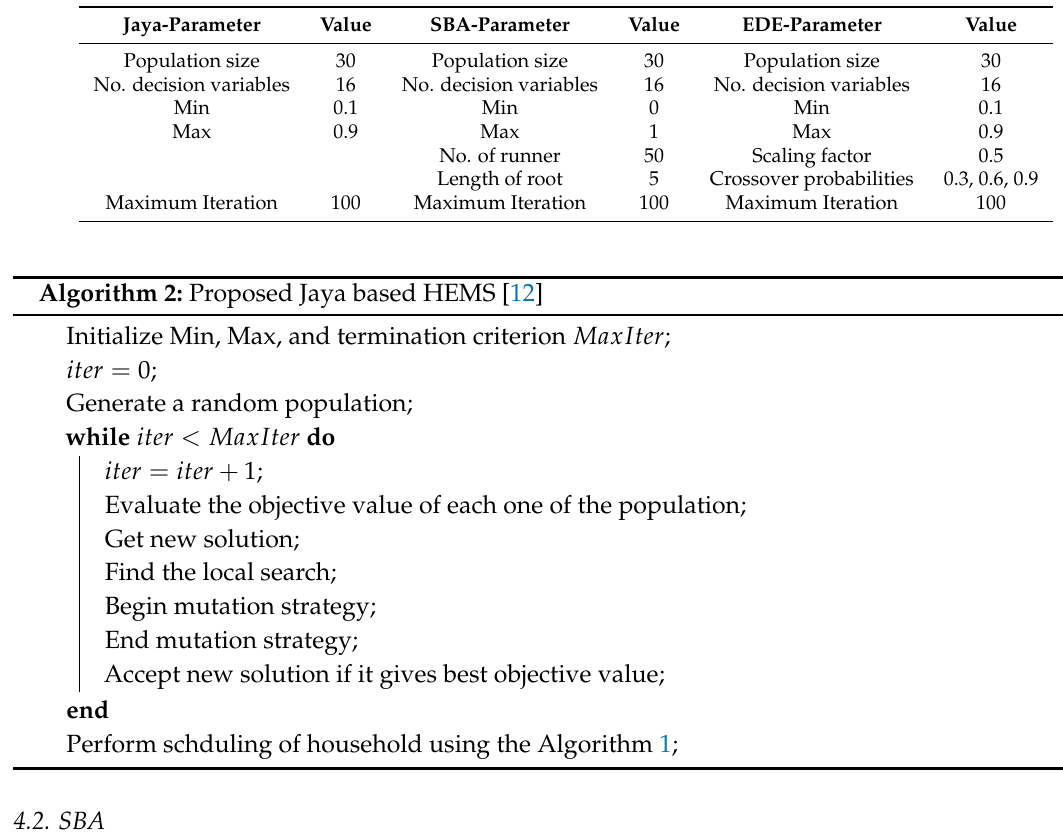
Table 3. Algorithms parameters. Max and Min denote the maximum and minimum population bound.